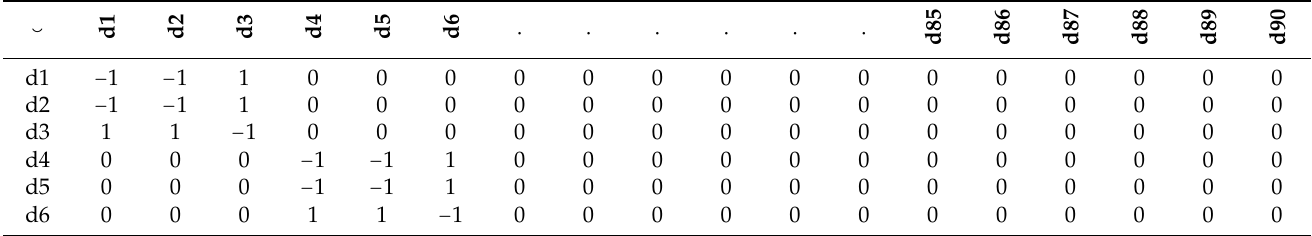
Table A8. Cup product of the cocycles deduced from the homeomorphic representation of Figure 20